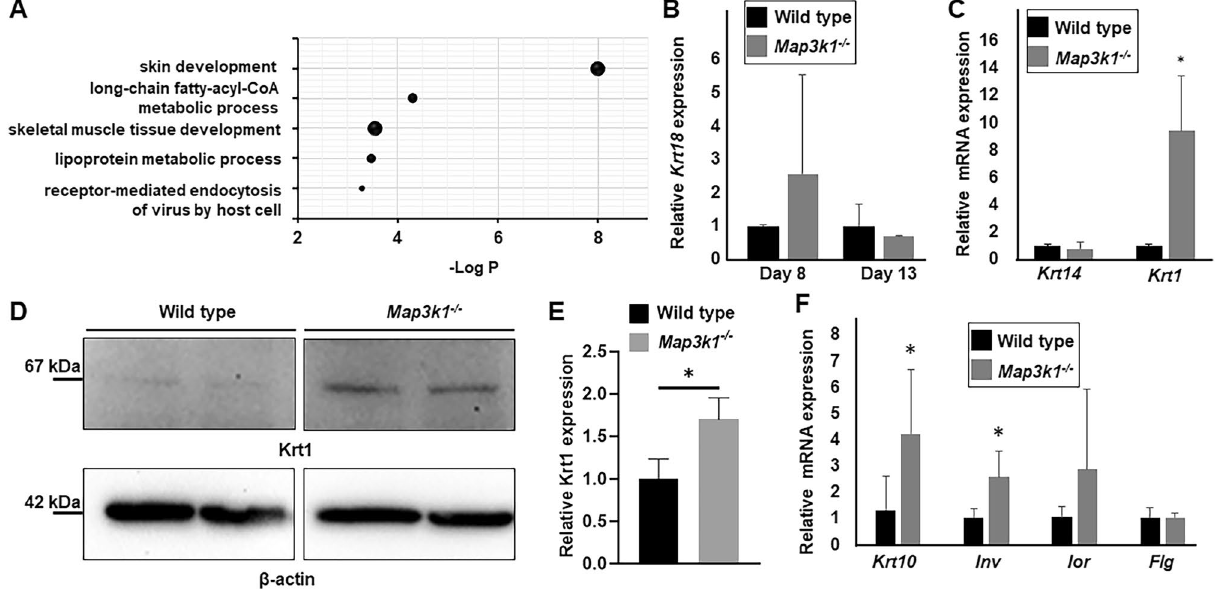
Figure 3. MAP3K1 loss-of-function enhanced suprabasal differentiation. ( A ) Differentially expressed genes in primary keratinocytes isolated from wild type and Map3k1 -/- mice were subjected to GO pathway analyses and the top biological functions up-regulated in the Map3k1 -/- versus wild type cells were shown. The wild type and Map3k1 -/- mESCs were differentiated in vitro for various times and examined for mRNA of ( B ) Krt 18 at the early phases, and ( C ) Krt 14 and Krt 1 and ( F ) Krt 10, Inv, Lor, and Flg , at the late phases (after 6 passages). The wild type and Map3k1 -/- D-KC were subjected to Western blotting using antibodies indicated ( D ) and results of at least 4 data sets were quantified ( E ). Original immunoblots corresponding to ( D and E ) are presented in Supplementary Fig. S1. The expression in Map3k1 -/- were compared to those in wild type cells, set as 1. * p < 0.05 is considered statistically